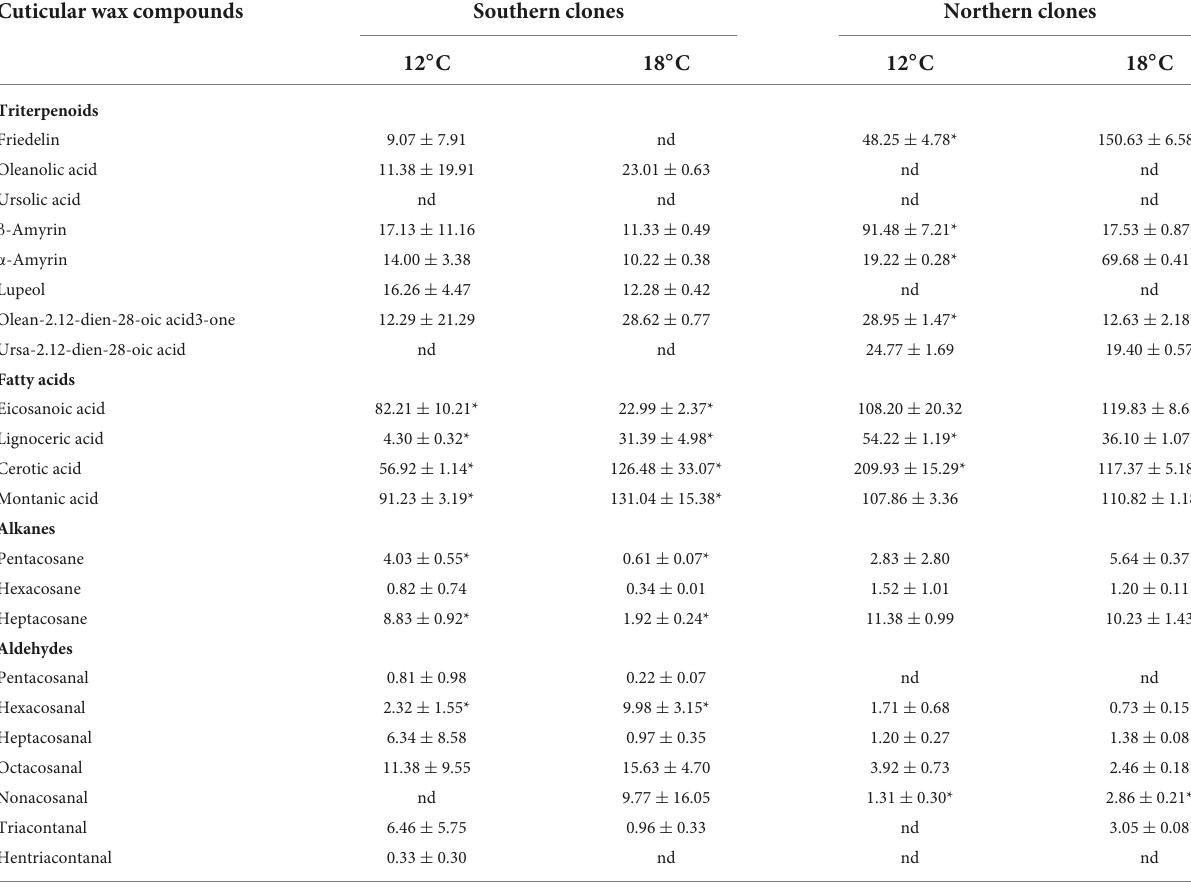
TABLE 3 Quantities ( µ g/mg of berry cuticular wax) of cuticular wax compounds in ripe bilberry wax in phytotron experiments. Cuticular wax